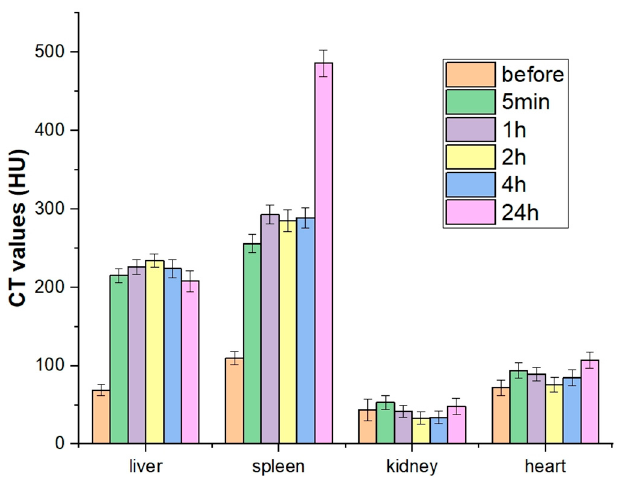
Figure 5. Time evolution of HU values registered for different mice organs after the intravenous injection of PEG@GdF 3 :Tb 3+ NPs (HU values before injection reported for the sake of comparison).